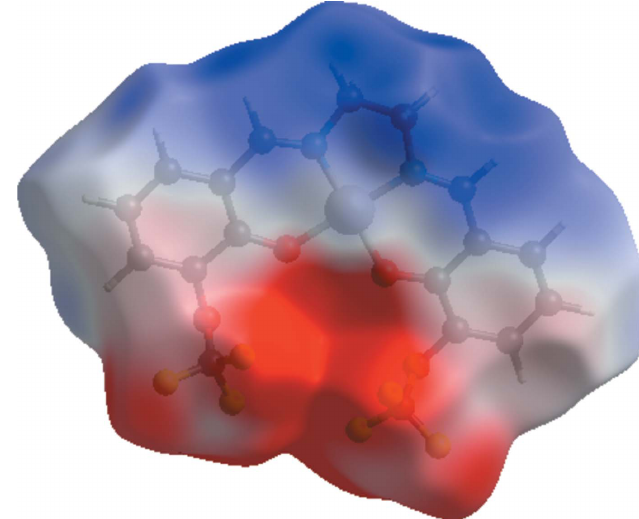
Figure 6 Electrostatic potential surface for the title compound.